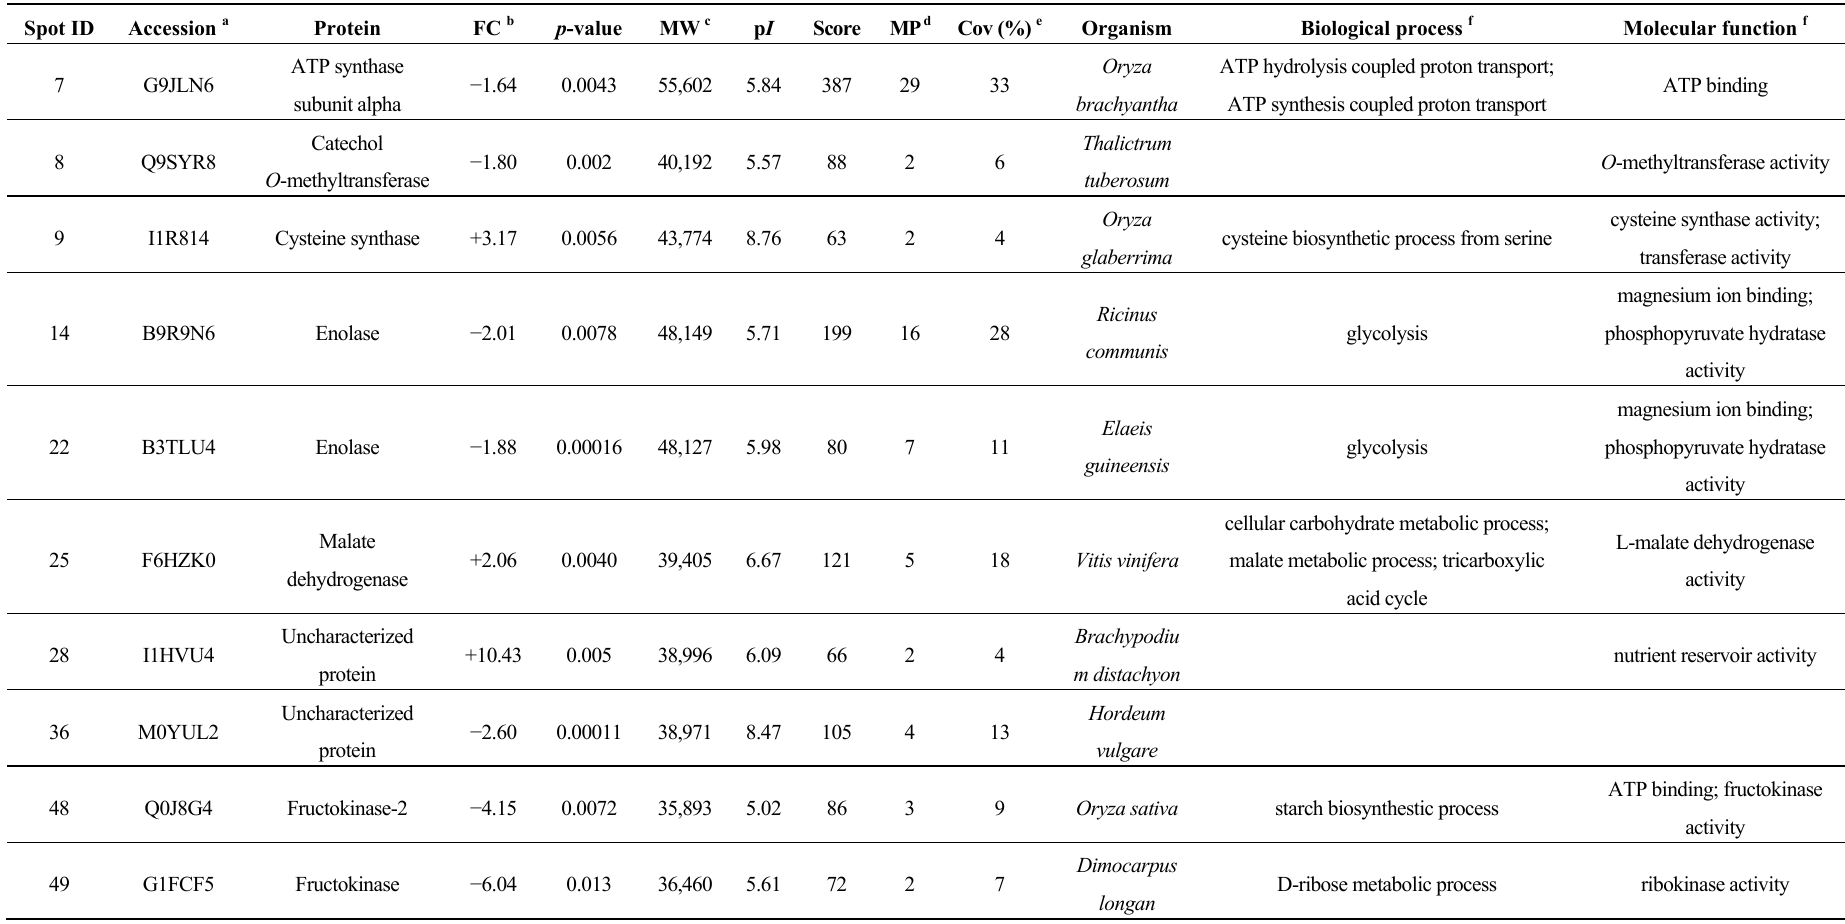
Table 1. List of identified proteins whose abundance were altered when oil palm roots were infected with G. boninense